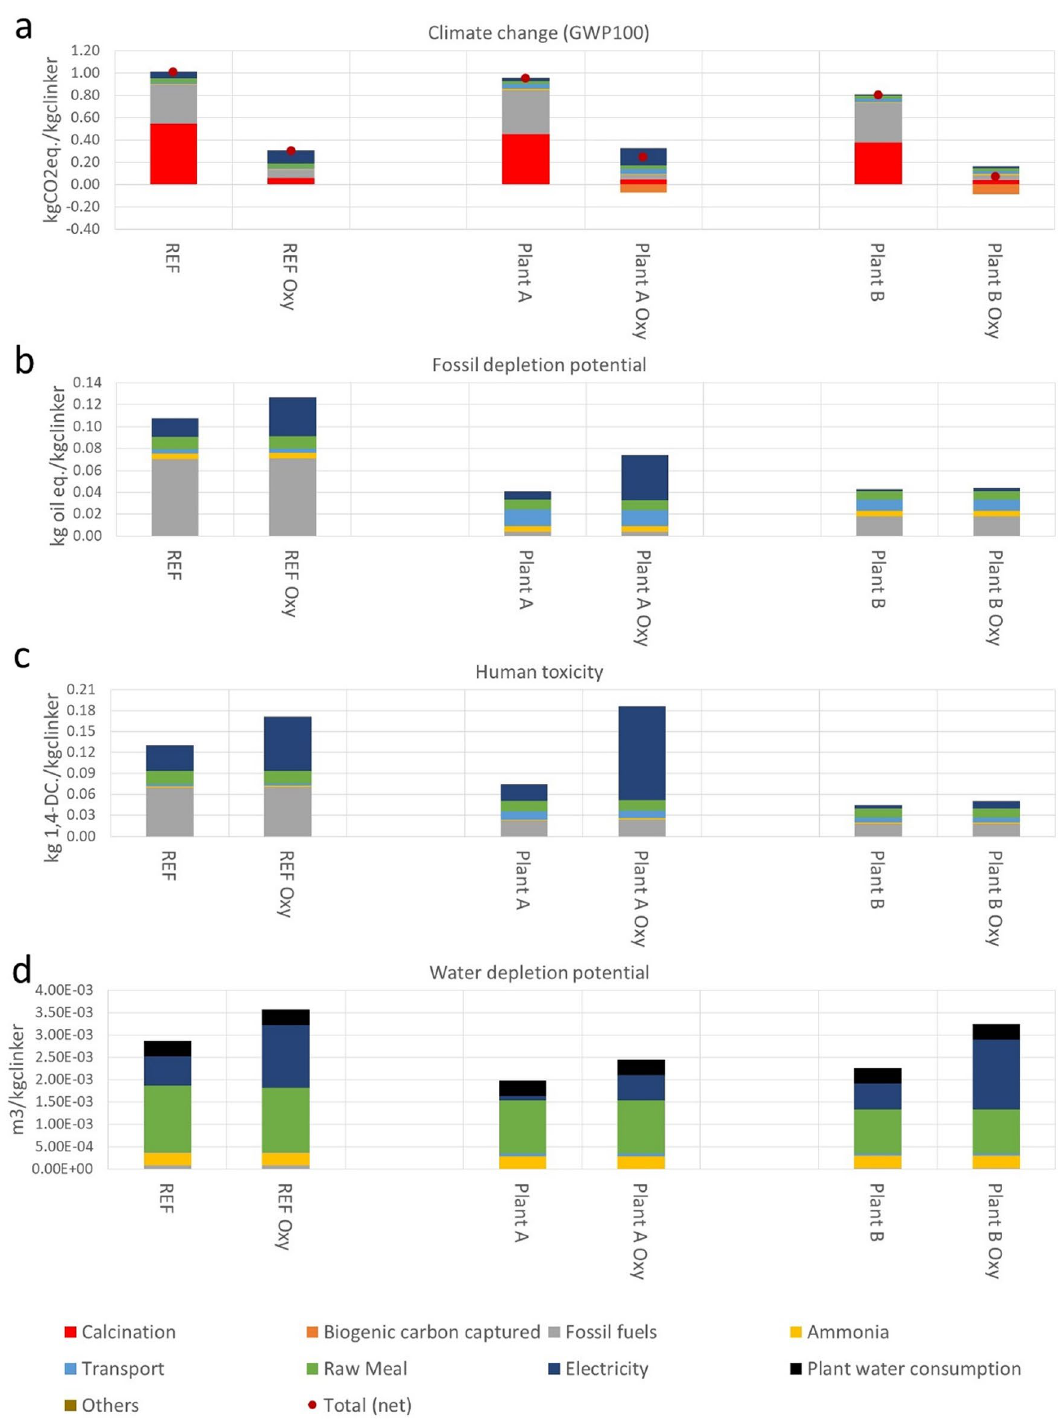
Figure 2. Selected life cycle environmental impact categories for the cement clinker production cases under conventional and oxyfuel CCS (Oxy). Impacts on climate change (GWP100) ( a ), fossil depletion potential (FDP) ( b ), human toxicity (HT) ( c ), and water depletion potential (WDP) ( d ). Plant A is located in Germany plant B in Sweden REF represent a reference plant based on average European cement